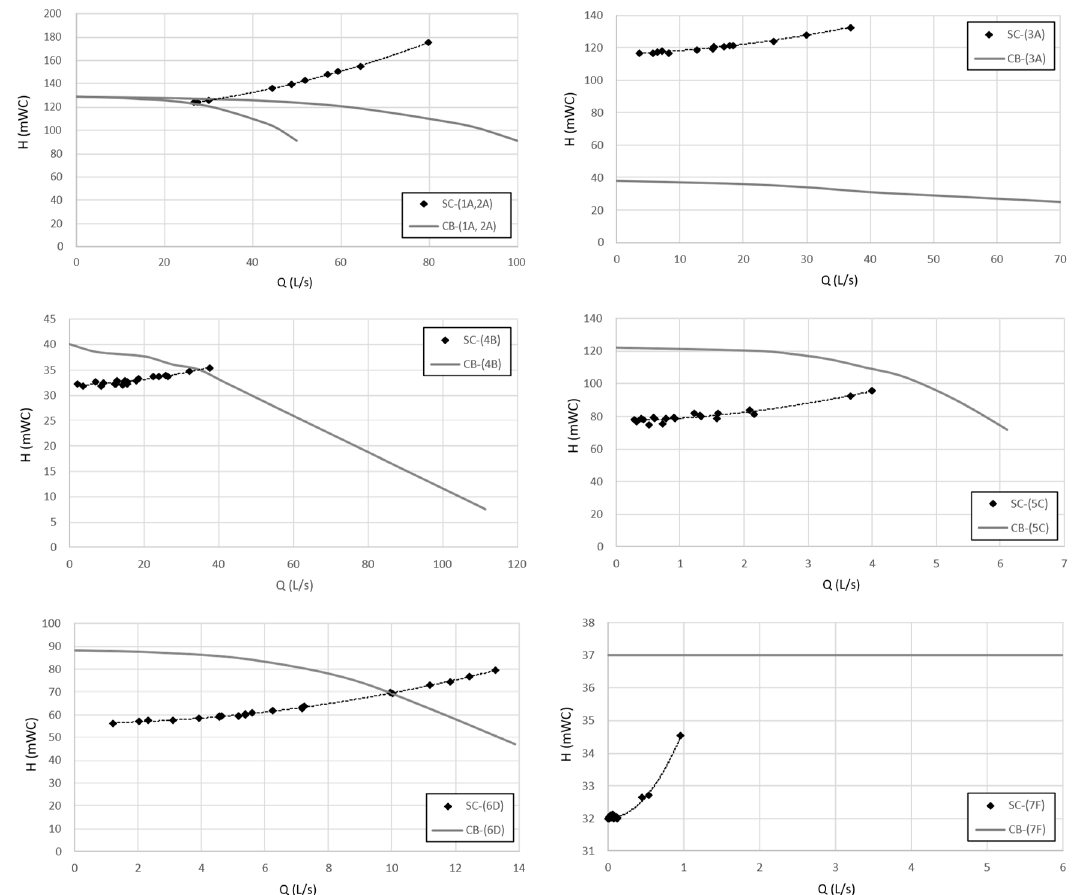
Figure 10. Setpoint curves (SC) and characteristic curves of the pumps (CB) for the pumping stations of the Richmond network.